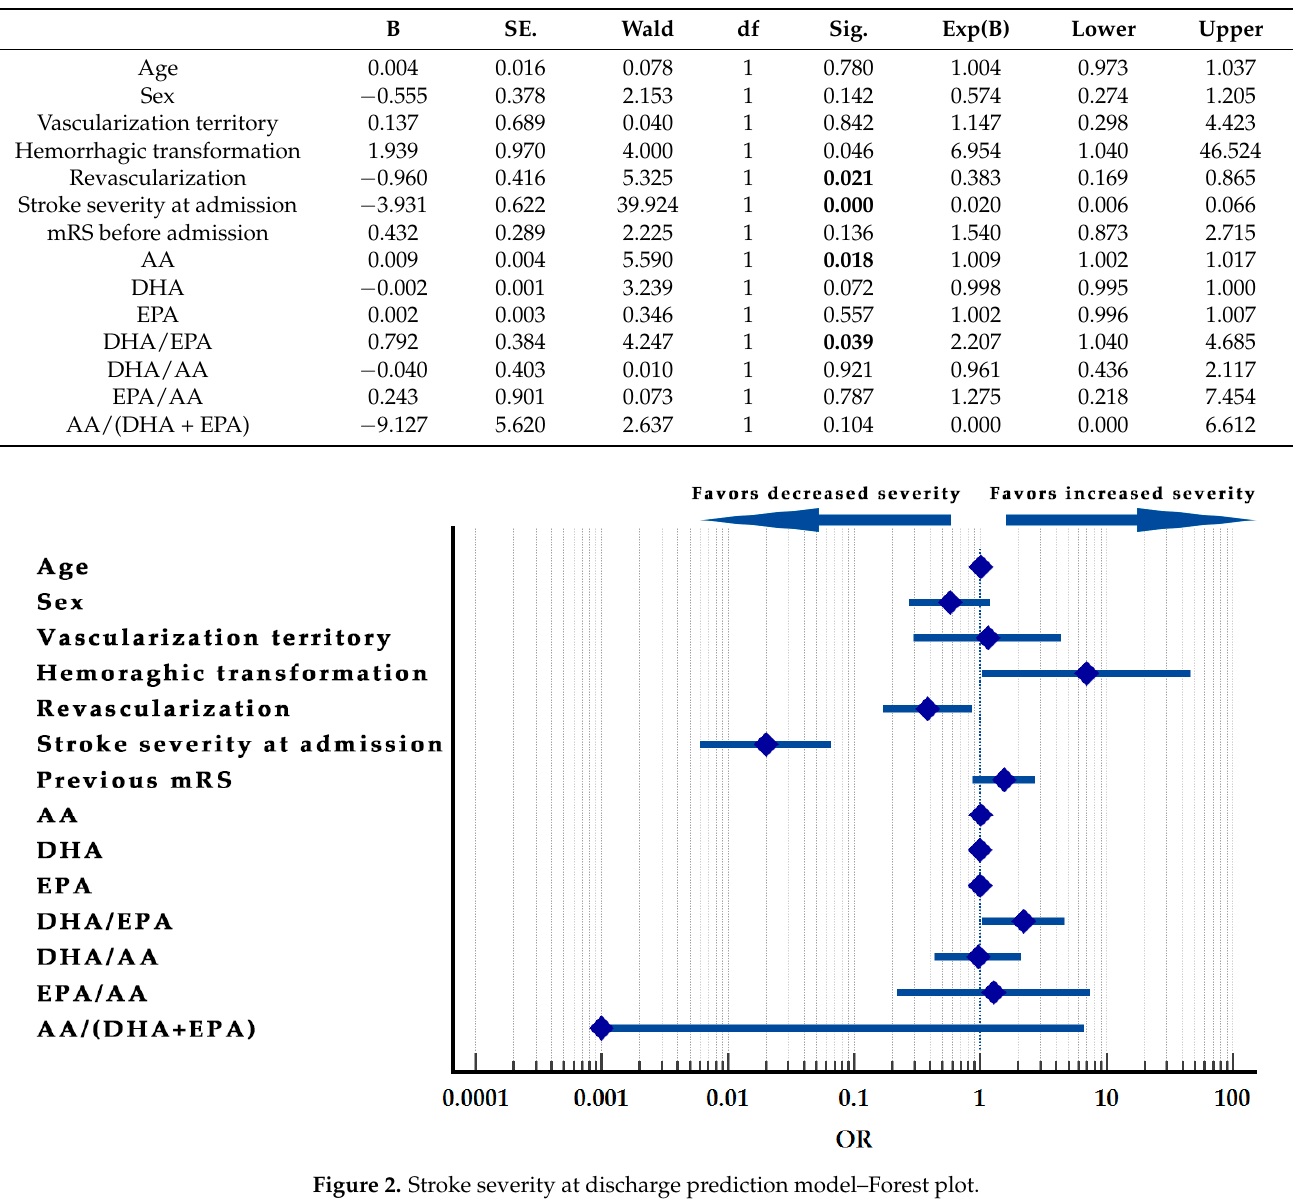
Table 11. Stroke severity at discharge prediction model.